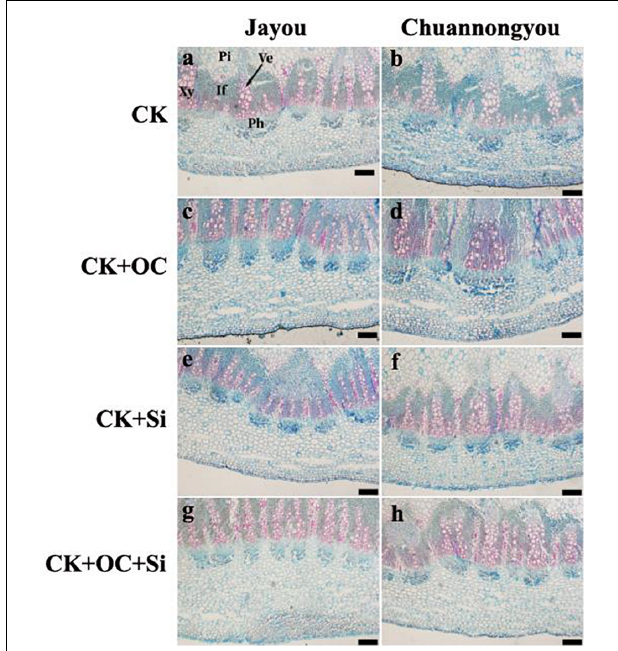
FIGURE 6 | Reflection of stem anatomical structure. Where, If, interfascicular; Ph, phloem; Pi, pith; Xy, xylem; Ve, vessel. Bar = 200 mm. The CK (A,B) , CK + OC (C,D) , CK + Si (E,F) , and CK + OC + Si (G,H) represent the conventional fertilization,conventional + organic carbon fertilization, conventional + silicon fertilization treatment, and conventional + organic carbon + silicon fertilization treatment.